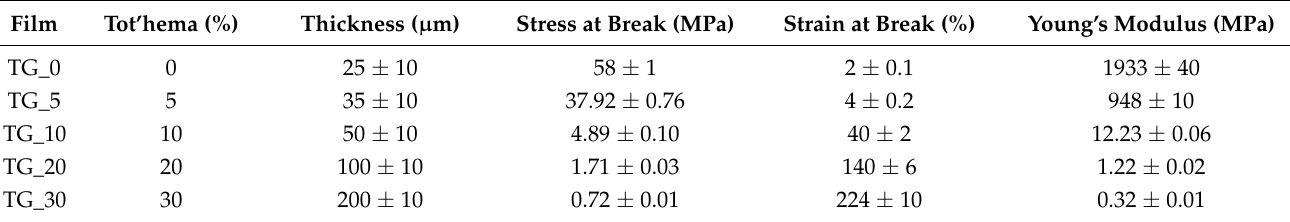
Figure 2. ( a ) SEM image of hexagonal microlenses array; ( b ) Interference fringe pattern of a microlens; and ( c ) 2D surface profile of a microlens. Table 1. The film thickness, stress at break, strain at break and Young’s modulus.